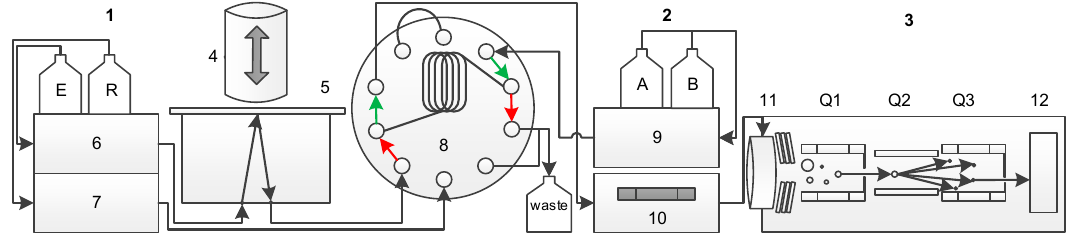
Figure 1. Flow scheme of the automated DBS-LC-MS/MS approach: 1, Automated dried blood spot (DBS) system; 2, HPLC; 3, MS/MS; 4, Extraction head; 5, DBS card; 6, Extraction pump; 7, Rinsing pump; 8, 10-port valve interface; 9, HPLC pump; 10, HPLC oven and analytical column; 11, ESI source; and 12, detector.